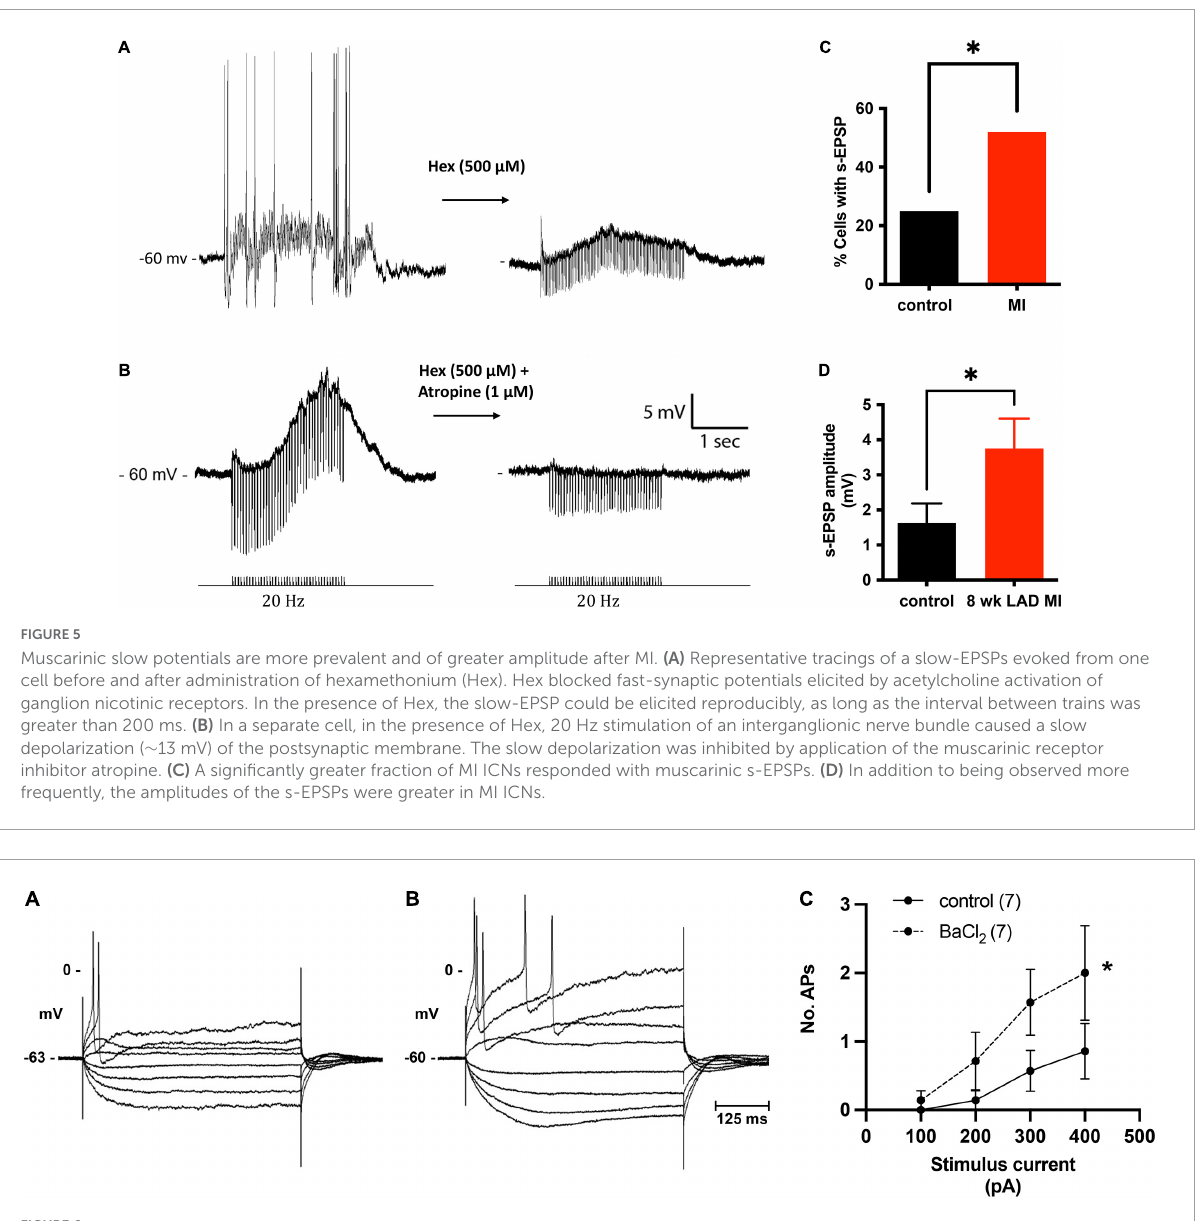
FIGURE6 Inhibition of M-current by bath application of BaCl 2 identifies role of M-current in regulation of pig ICN excitability. (A,B) Membrane potential tracing showing a typical response from a control ICN in control PSS and after extracellular addition of BaCl 2 (1 mM). Barium